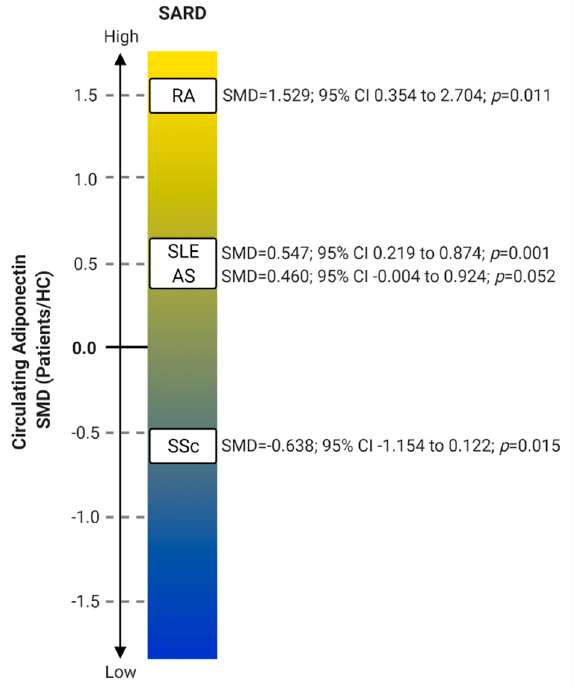
Figure 3. Adiponectin circulating levels observed in certain SARDs. The values are presented as standard mean difference (SMD) with 95% confidence intervals (CI) and association p values. The most recent meta-analysis with the highest number of studies included was presented for each SARD. AS: Ankylosing spondylitis, HC: Healthy controls, RA: Rheumatoid arthritis, SLE: Systemic lupus erythematosus, SSc: Systemic sclerosis.